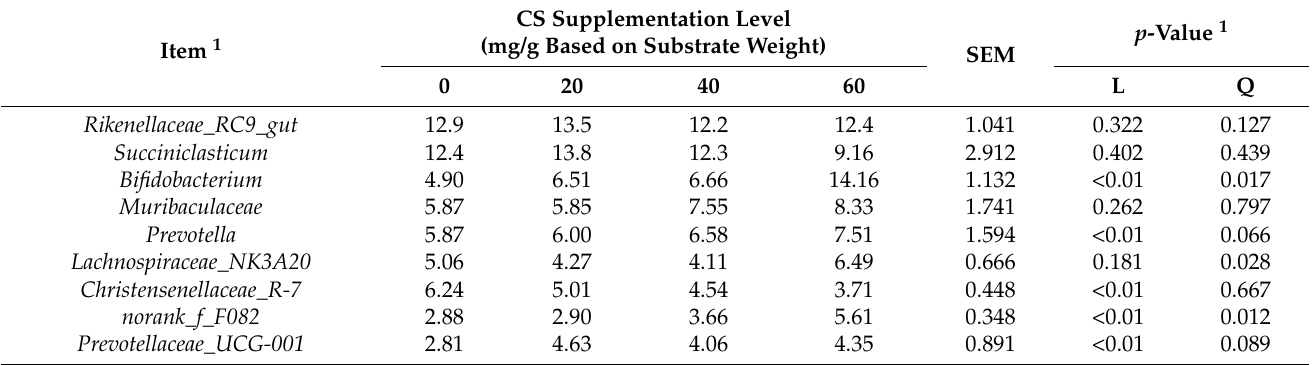
Table 7. Microbial community analysis at the genus level (relative abundance > 1%) of microbiomes with increasing CS supplementation level in LF